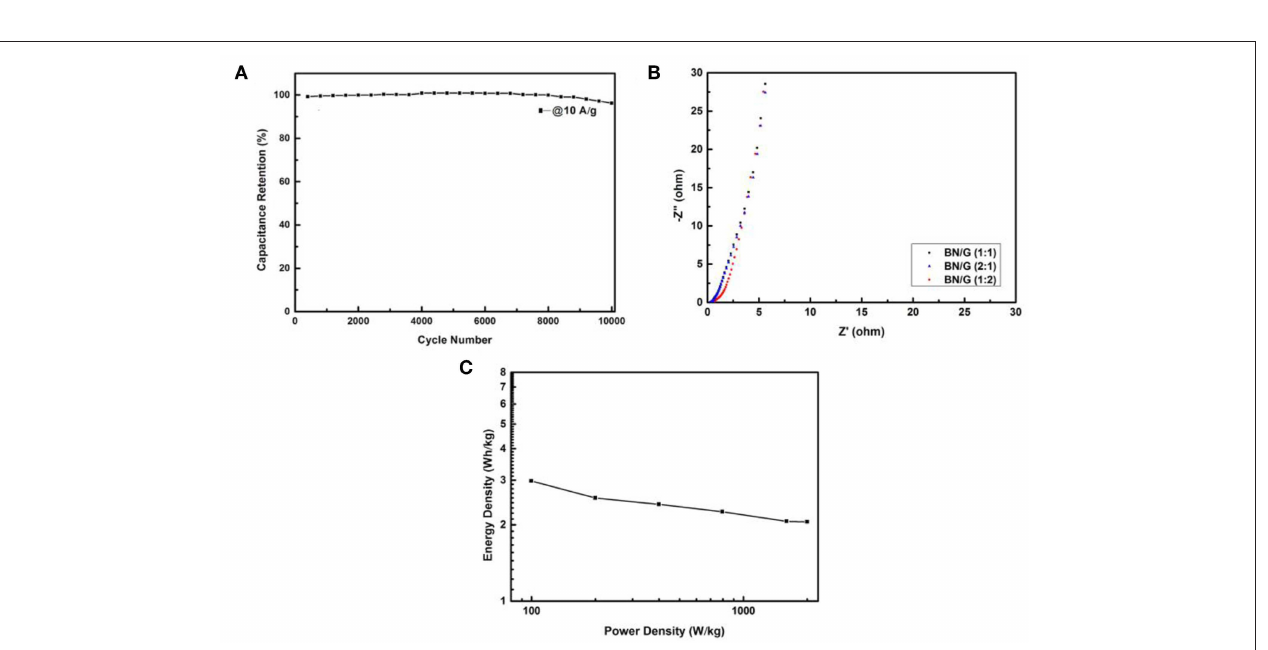
Frontiers in Chemistry |